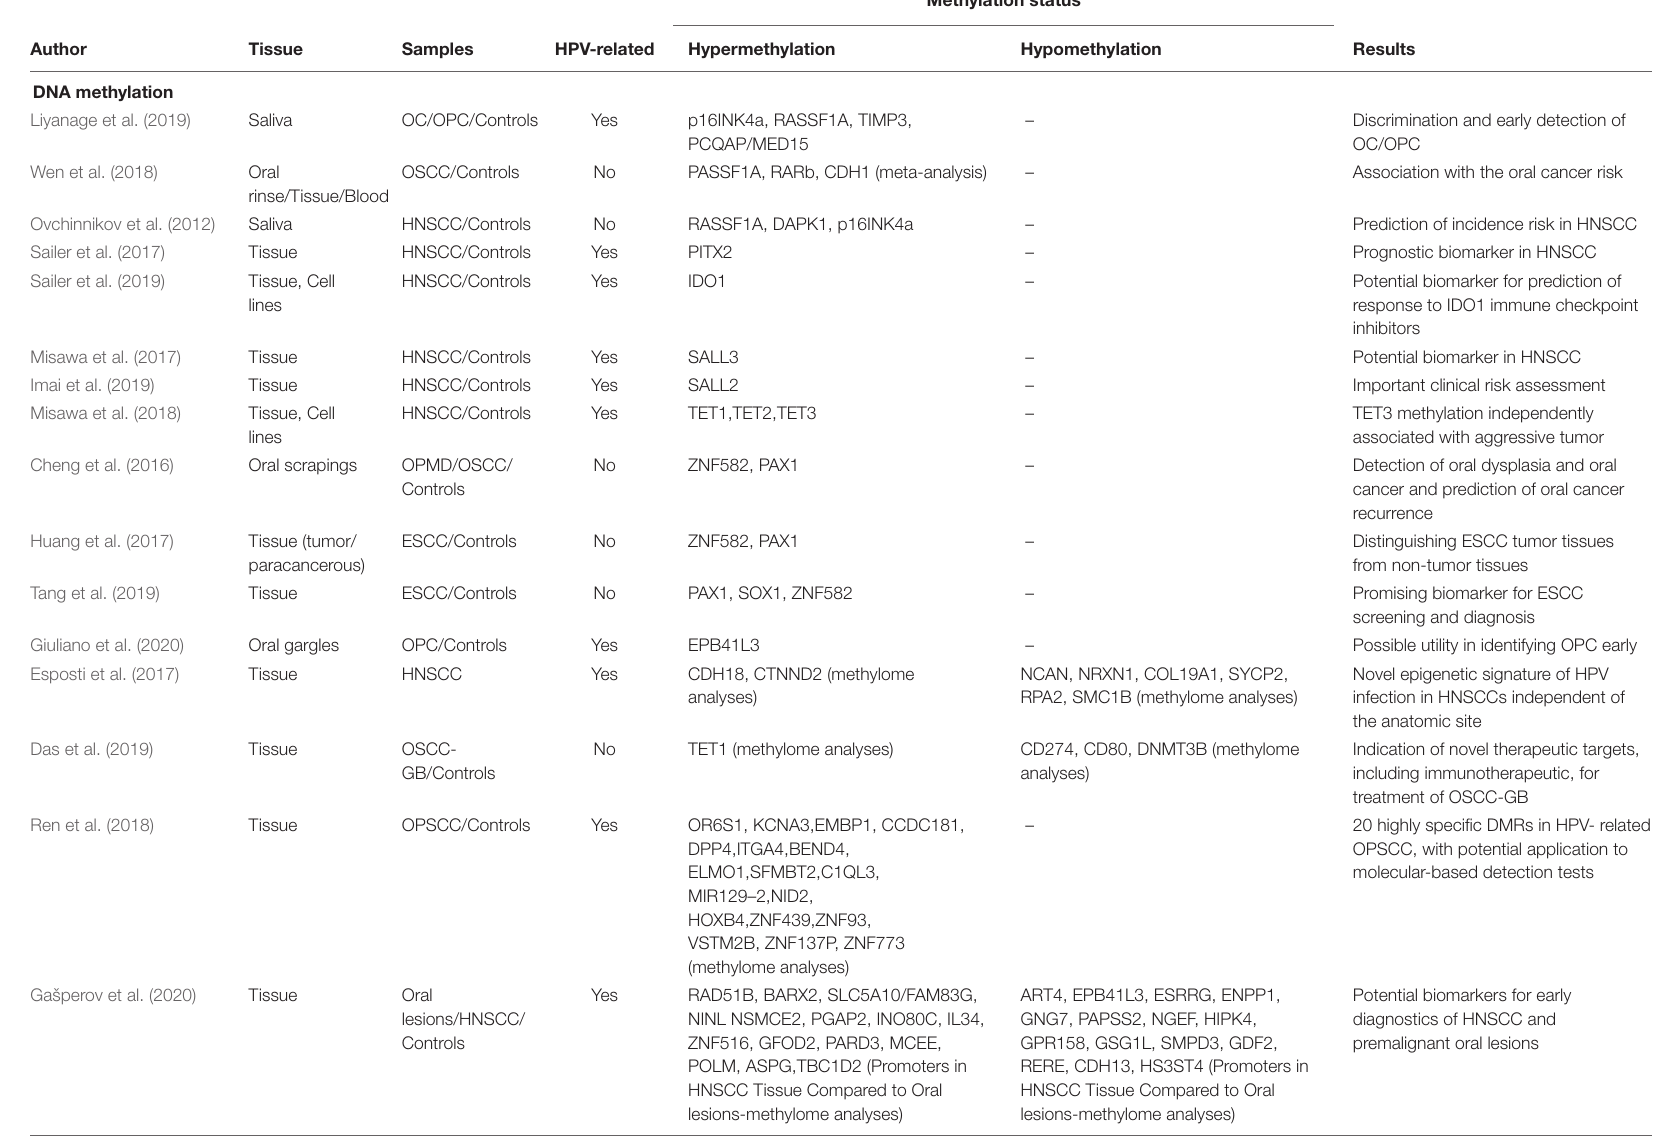
TABLE 1 | Epigenetic mechanisms related in